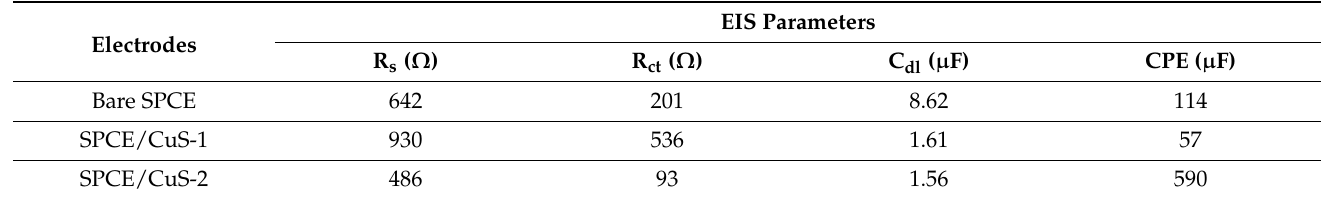
Table 1. EIS data of the Bare SPCE, SPCE/CuS-1, and SPCE/CuS-2 in [Fe(CN) 6 ] 3 − /[Fe(CN) 6 ] 4 −